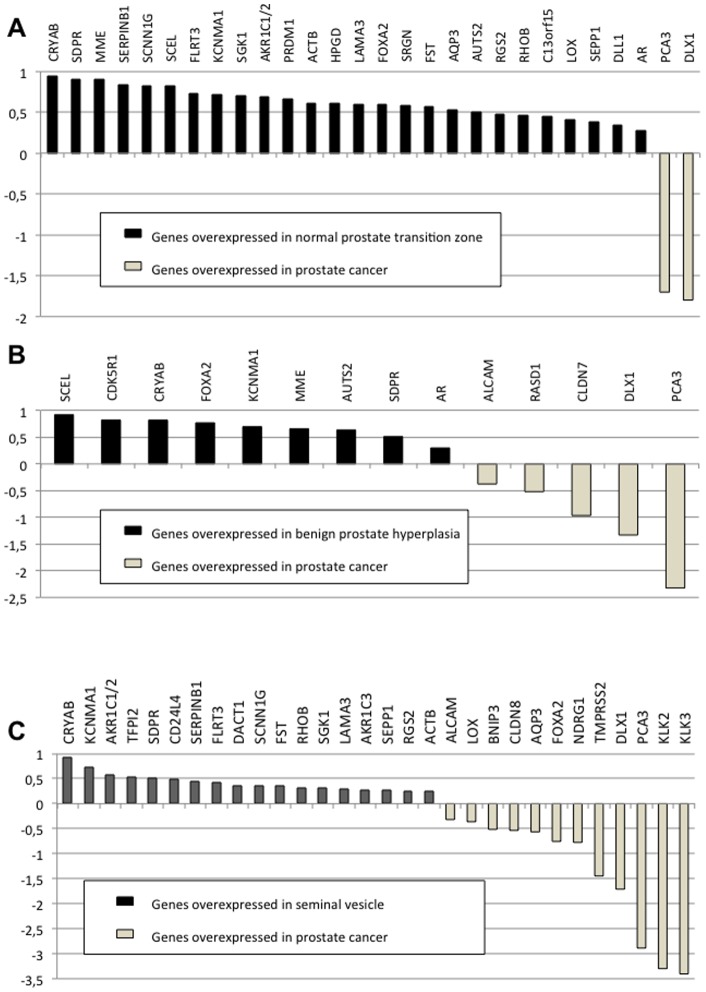
Log10RQ bar chart of significant expression changes.Y-axis: log10 of RQ (relative quantities); X-axis: genes whose expression was statistically significantly different between: A) 26 matched normal prostate transition zone and prostate cancer samples B) 27 prostate cancer samples and 15 samples of benign prostatic hyperplasia C) 35 matched seminal vesicle and prostate cancer samples.